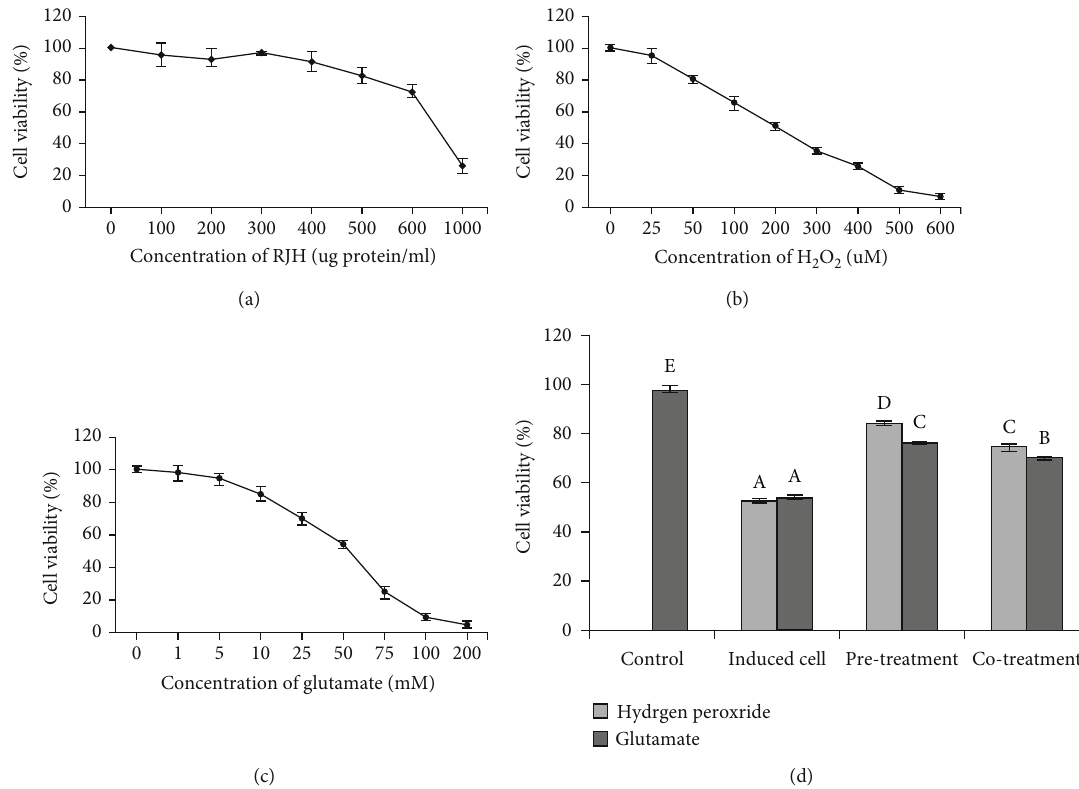
Figure 2: Cytoprotective neuroprotective activity of Flavourzyme-treated RJH at 240 min hydrolysate by pretreatment and cotreatment of hydrogen peroxide- and glutamate-induced SH-SY5Y cell damage. The e ff ect of (a) RJH, (b) H viability and (d) the protection of RJH on H have mean values that are signi fi cantly di ff erent ( p < 0 : 05 ).